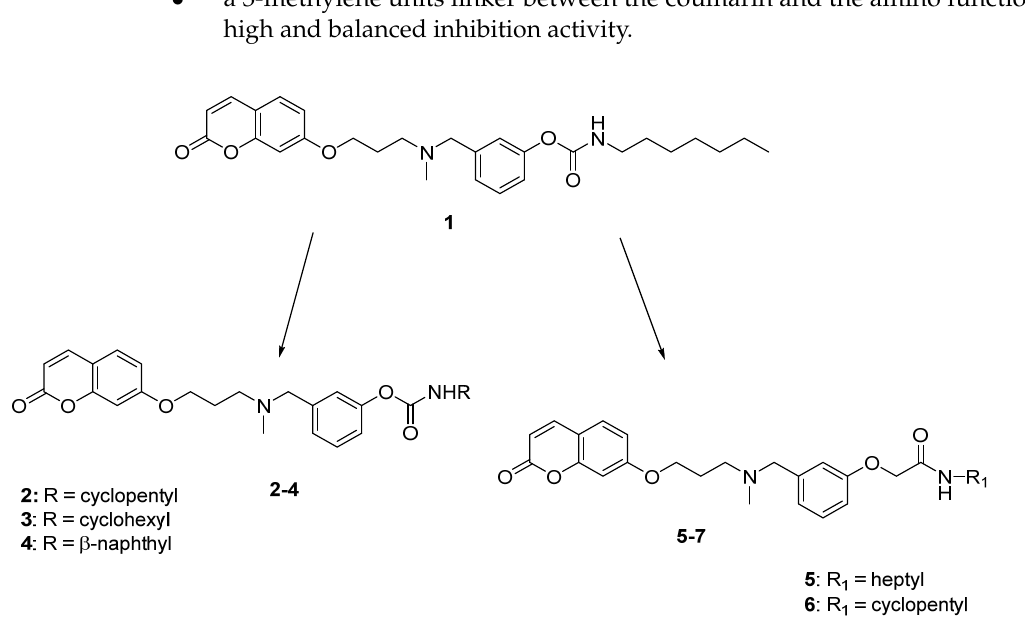
Figure 1. Structure of lead compound 1 and design strategies for the new compounds.